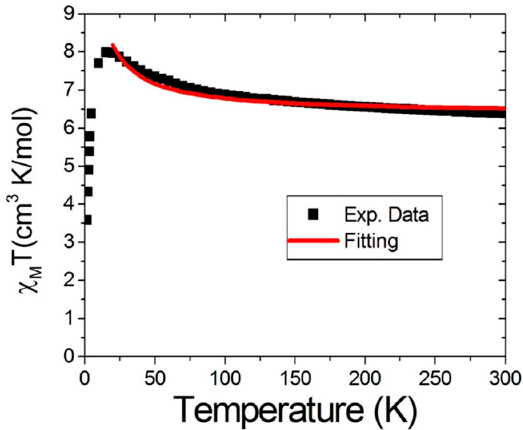
Figure 4. χ M T vs. T plot under a magnetic field of 1000 G in the 2~300 K range for compound 1 . The black square represents the experimental data, and the solid red line is the best fit for the data using Equation (2).